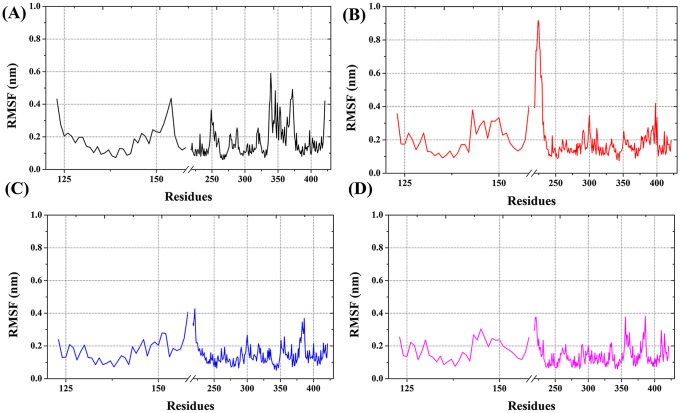
The root mean square fluctuation of VDR models VDRapo (black), VDR1α25(OH)2D3 (red), VDRCTA-091 (blue), VDRCTA-018(pink).